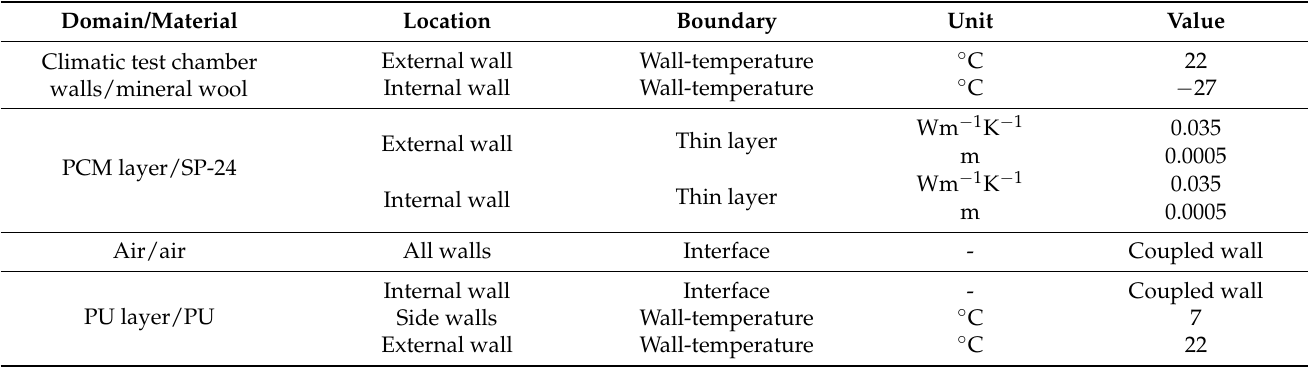
Table 4. Boundary conditions employed during calculation in time-dependent